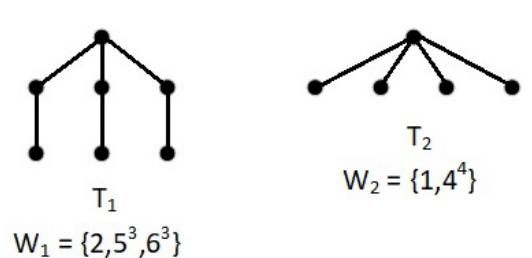
Figure 3. T 1 is the only tree with gcws {2, 5 3 ,6 3 }, which is not a caterpillar.